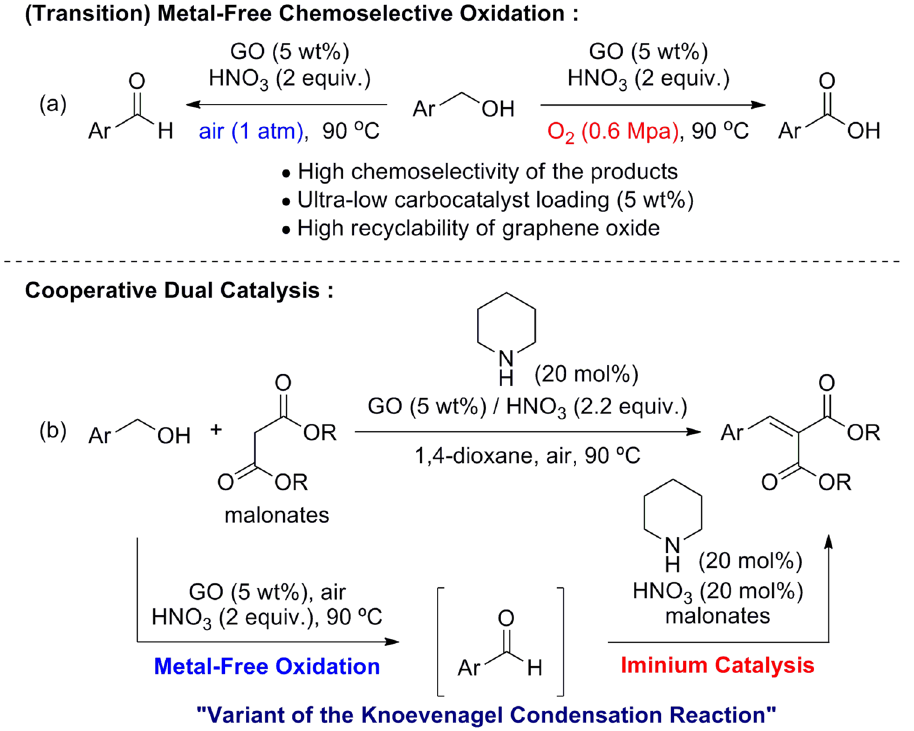
Figure 2. Chemoselective oxidations ( a ) and their application to a variant of the Knoevenagel condensation reaction ( b